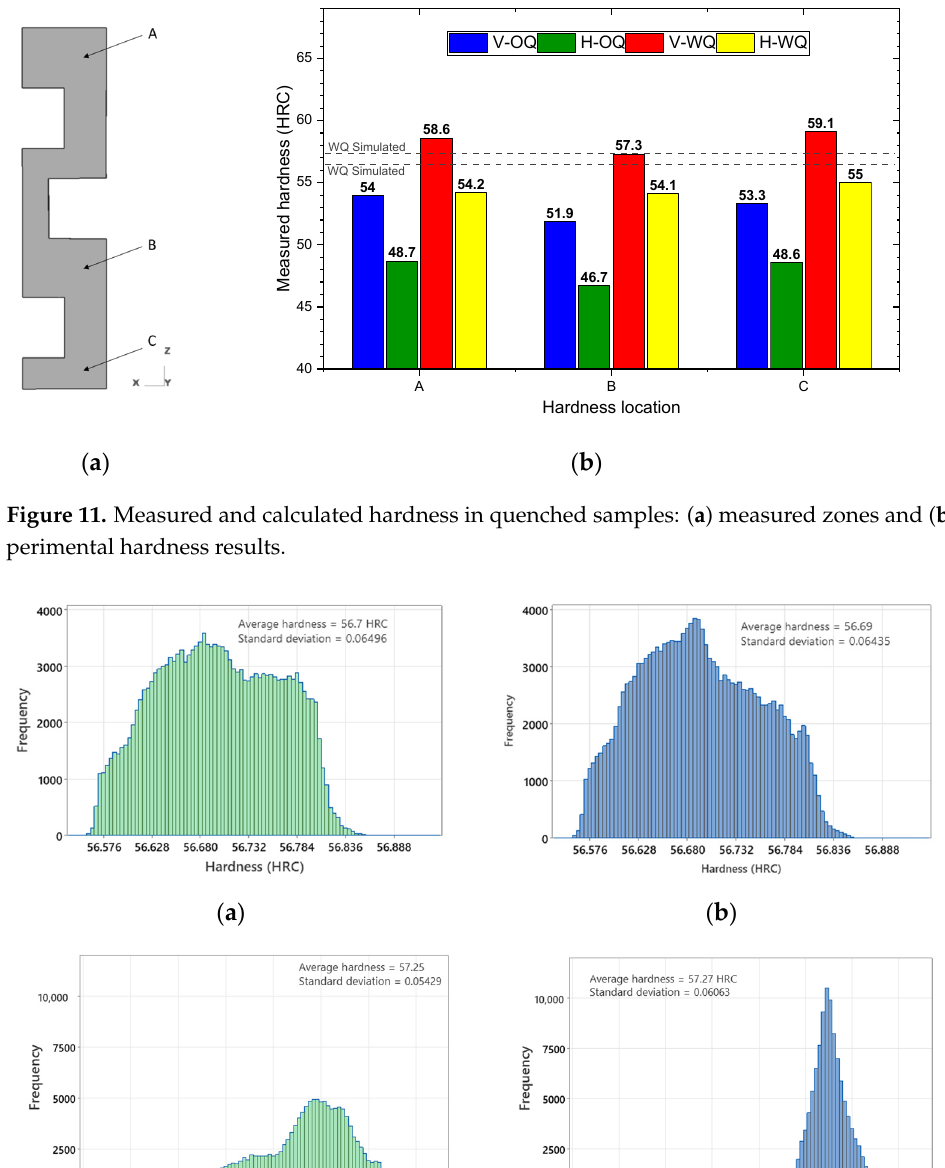
Figure 10. Martensite distribution in samples: ( a ) vertical oil quench; ( b ) horizontal oil quench; ( c ) vertical water quench; and ( d ) horizontal water quench.